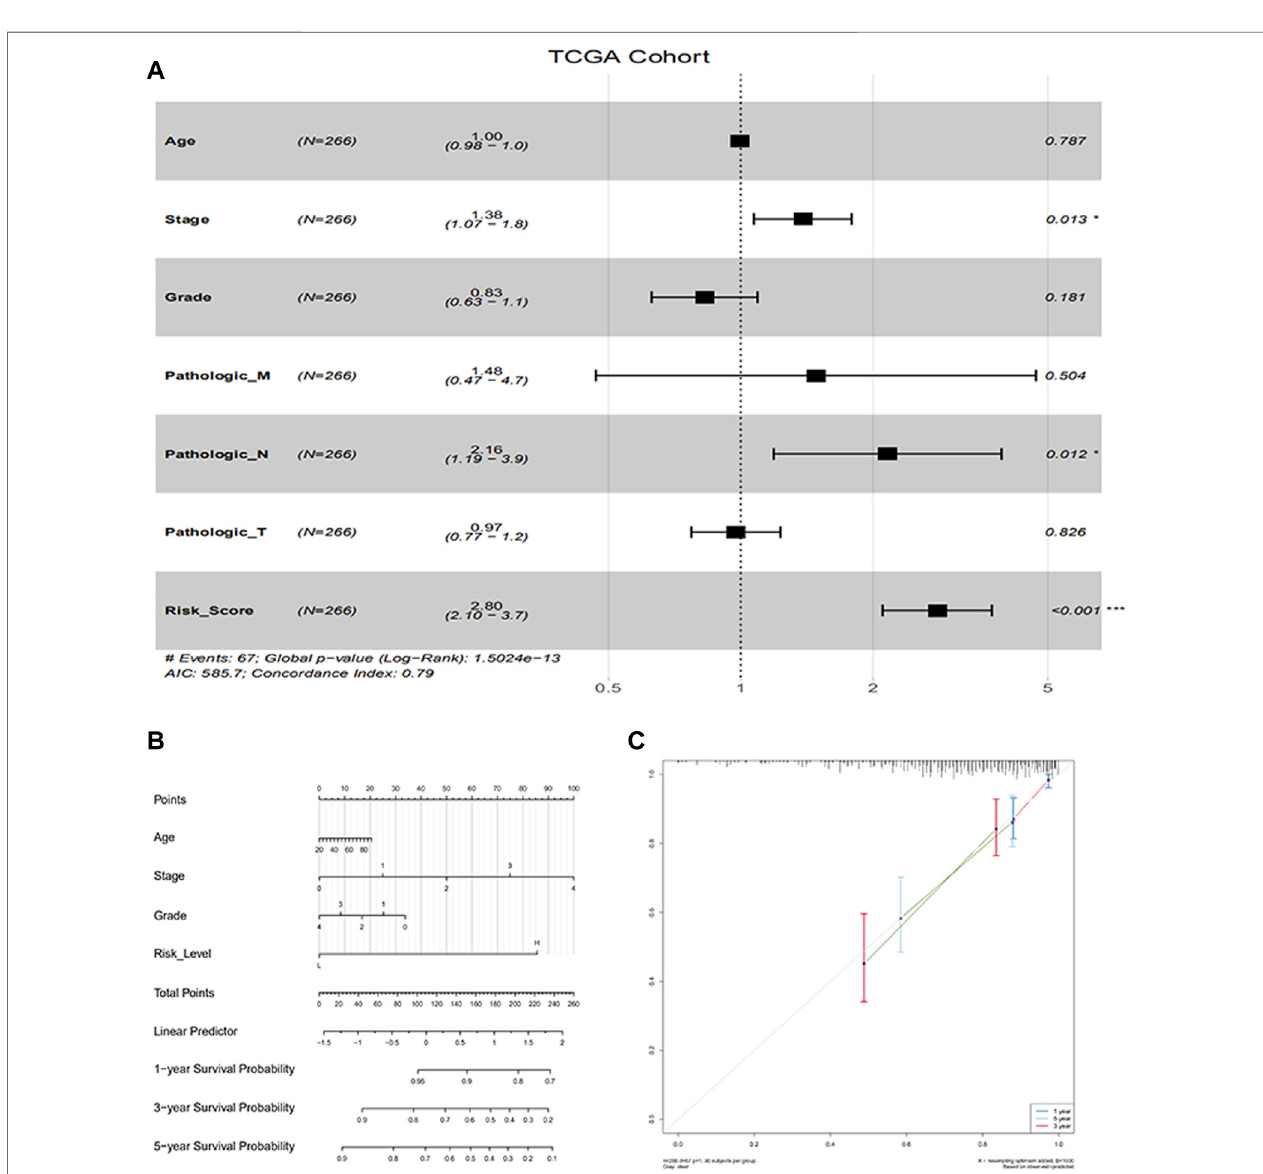
FIGURE 3 | Evaluation of factors in impacting prognosis of patients for CC. (A) Multivariable Cox proportion hazard regression for OS of CC; (B) Nomogram comprisedriskscoresandotherclinicalparametersforthepredictionof1-,3-,and5-yearOSofCC; (C) Calibrationplotofthenomogramforprobabilisticforecastsof1-, 3-and 5-year overall survival of